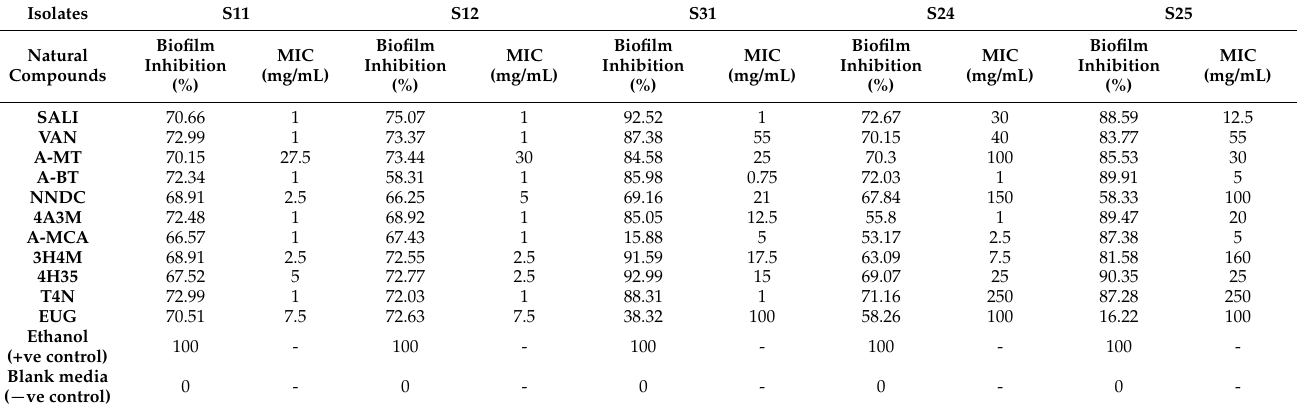
Table 2. Minimum inhibitory concentration (MIC) and percentage biofilm inhibition exhibited by the natural